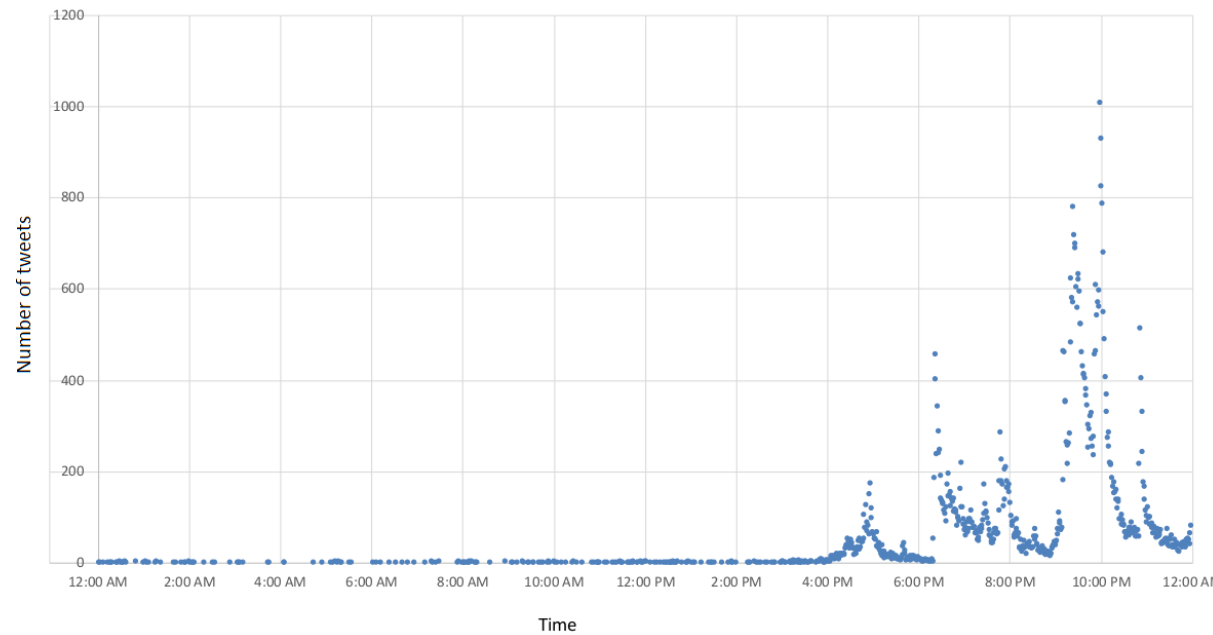
Figure 2. The number of tweets by the minute on March 11,